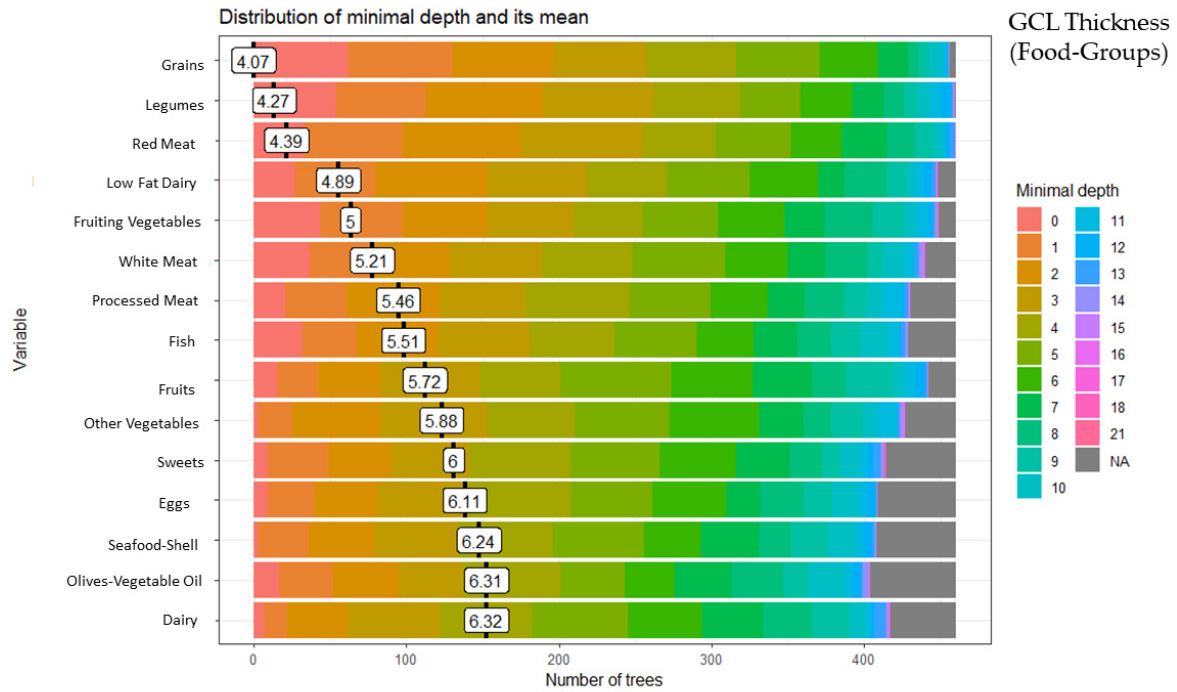
Figure 1. Random forest food group and retinal nerve fiber layer (RNFL).